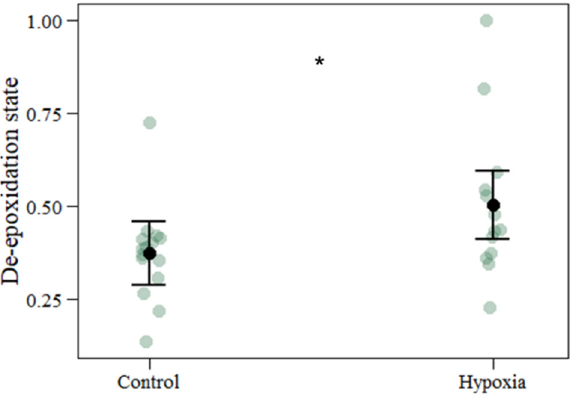
Figure 3. De-epoxidation state of coral fragments exposed to control and hypoxic conditions. The values represent mean and standard deviation, asterisks indicate significant differences between the treatment groups at: p < 0.05 (*) (control n = 15; hypoxia n = 13). The n denotes number of coral samples assessed in the analysis. CI from the model and each measurement point are represented.